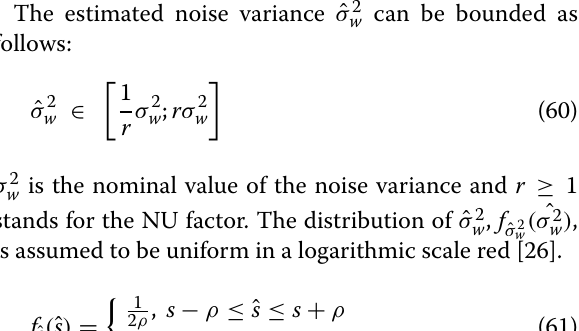
The estimated noise variance ˆ σ 2